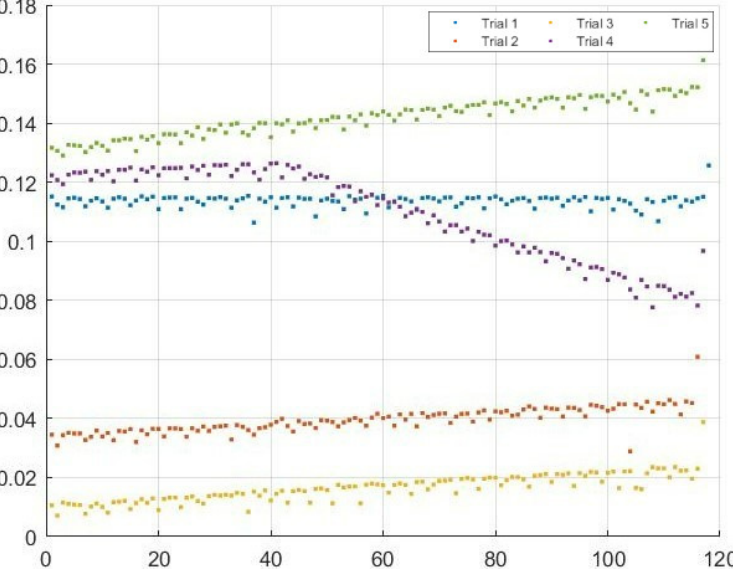
Figure 25. Delay in seconds of 120 packets transmitted during five trials over the Ethernet connection to the host GNU radio